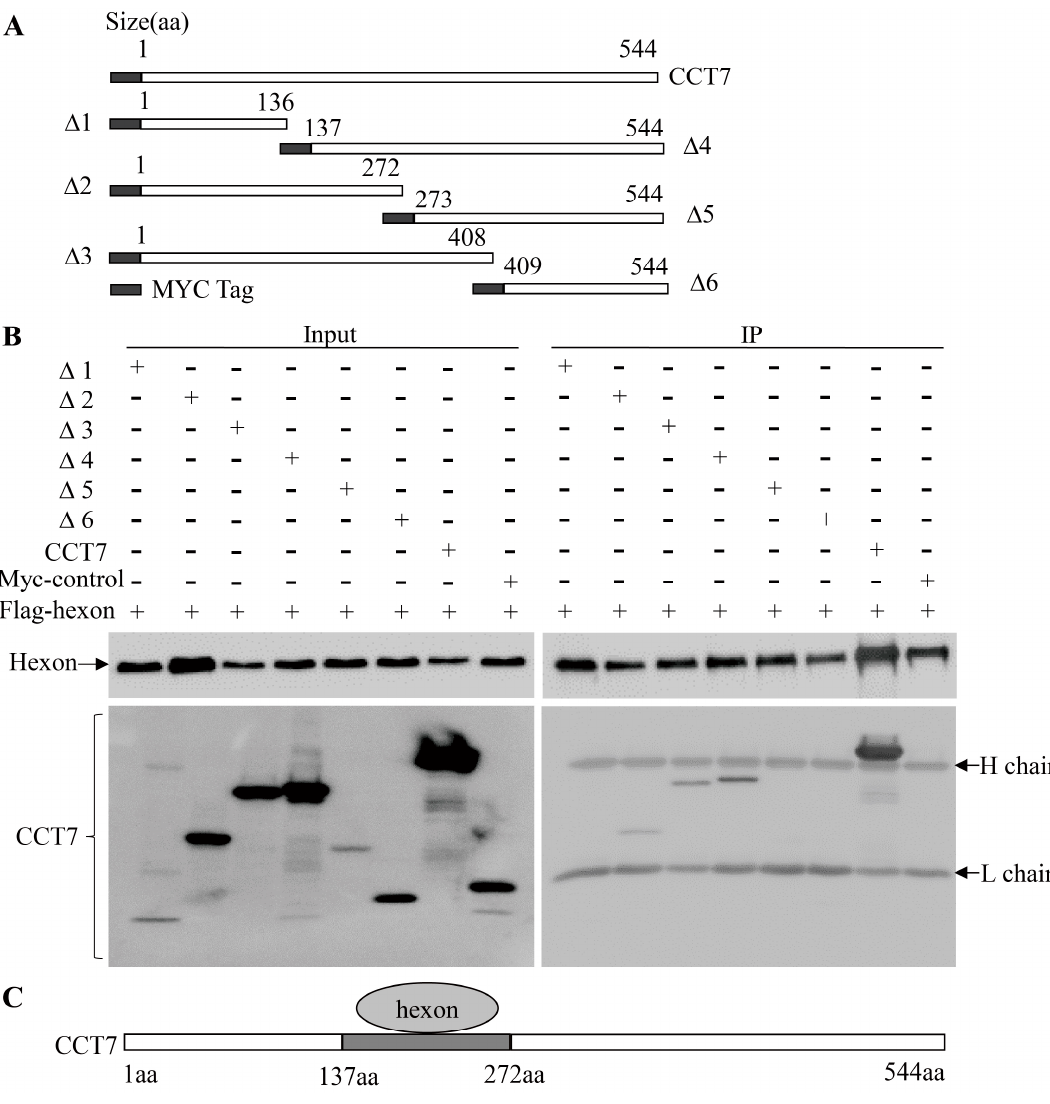
Figure 5. The portion of CCT7 from amino acids 137–272 is responsible for binding to hexon. ( A ) Schematics represent the genes encoding the full-length CCT7 and truncated CCT7 molecules (from ∆ 1 to ∆ 6). ( B ) Interaction of Flag-hexon with different truncated CCT7 mutants. LMH cells were transfected with full-length pCMV-myc-cct7, the indicated truncated mutants or pCMV-myc-control (encode a 17kDa control protein). Cell lysates were prepared and immunoprecipitated with anti-Flag McAb. The pellets were examined with Western Blot using anti-Myc and anti-FLAG antibodies. ( C ) Schematic representing the domain (137–272aa) of CCT7 responsible for binding to hexon. The “H chain” means the heavy chain of antibody and the “L chain” means the light chain of antibody.